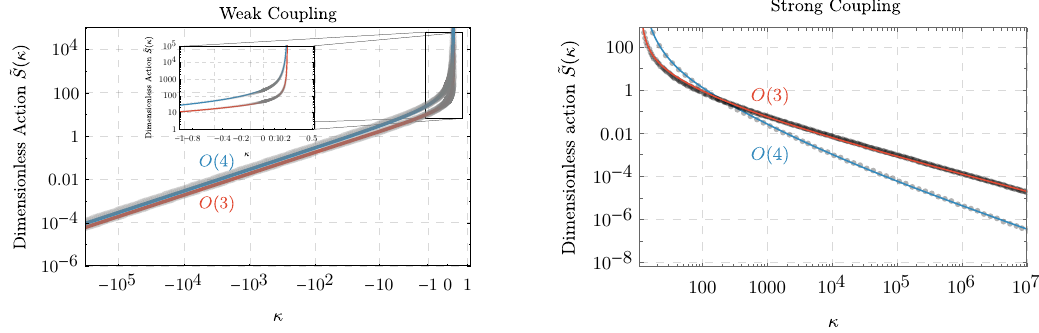
Figure 8 . Fits to data of the O(3), O(4) bounce actions in the κ parameterization. Left : results for the weakly coupled models, for the positive quartic potential in eq. (3.3), regularized over the Thin Wall limit in eq. (A.2) ( κ > 0 ), and the negative quartic, describing the BP limit in eq. (A.3) ( κ < 0 ). The numerical solutions are obtained using the FindBounce [19] Mathematica package, regularized over the TW(BP) solution, shown as data points. The solid curve interpolates the fitted solutions for the regularized bounce ˜ S ( κ ) ≡ B ± ˜ S TW(BP) ( κ ) . Right : results for the strongly coupled (de)confining PT. Here, we show the bounce shape functions ˜ S 3 , 4 ( κ ) = B 3 , 4 ( κ ) ˜ S TW 3 , 4 ( κ ) from eqs. (A.12) and (A.11). Clearly, for sufficiently large | κ | the O(4) symmetric action dominates the tunneling rate, implying that quantum fluctuations drive the